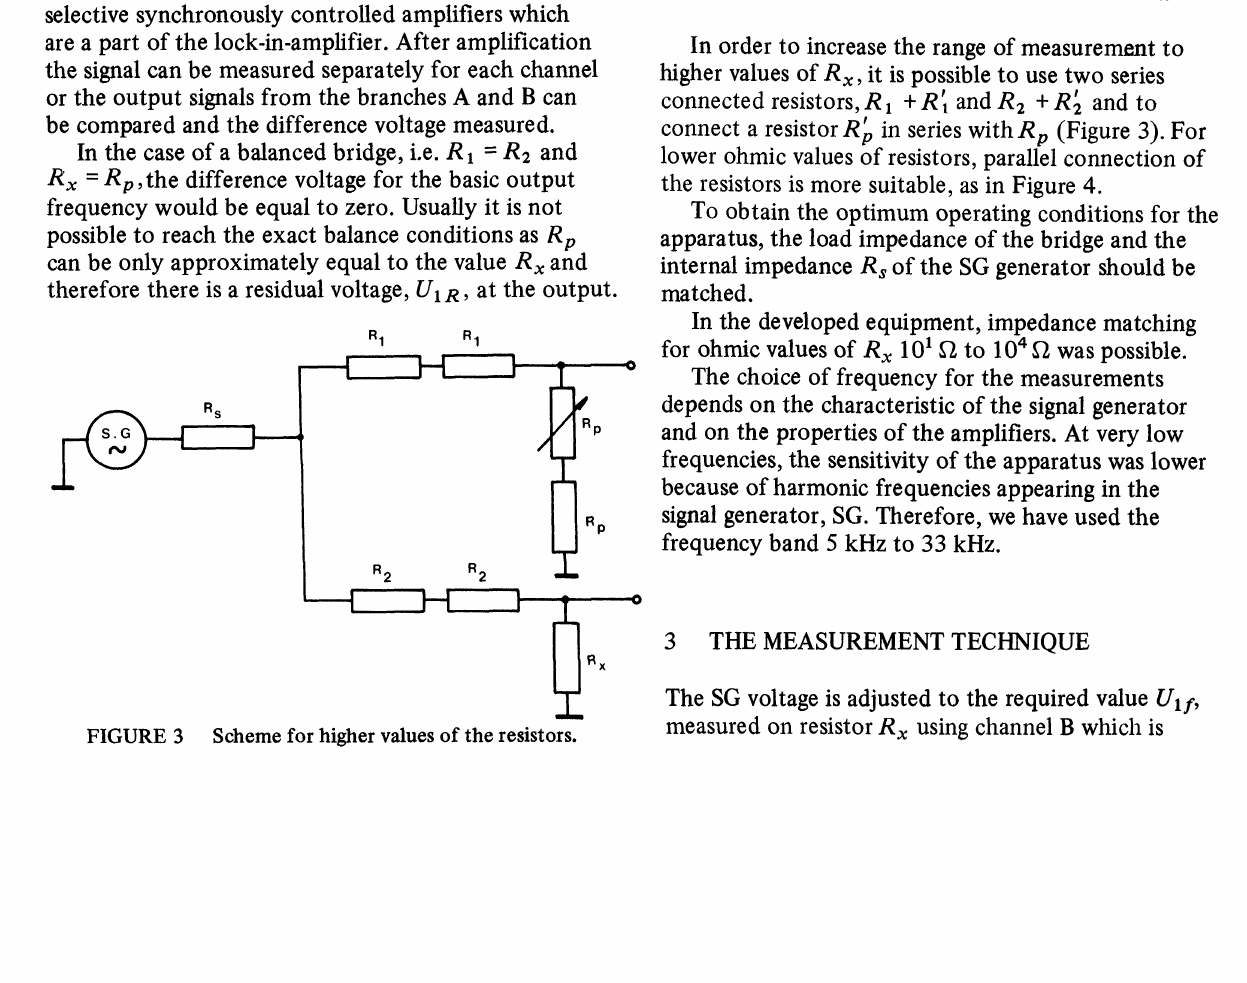
FIGURE 4 Scheme for lower values of the